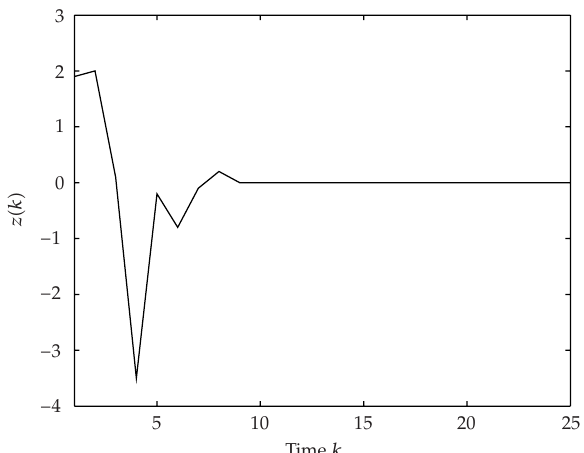
Figure 4: Controlled output signal of the closed-loop switched